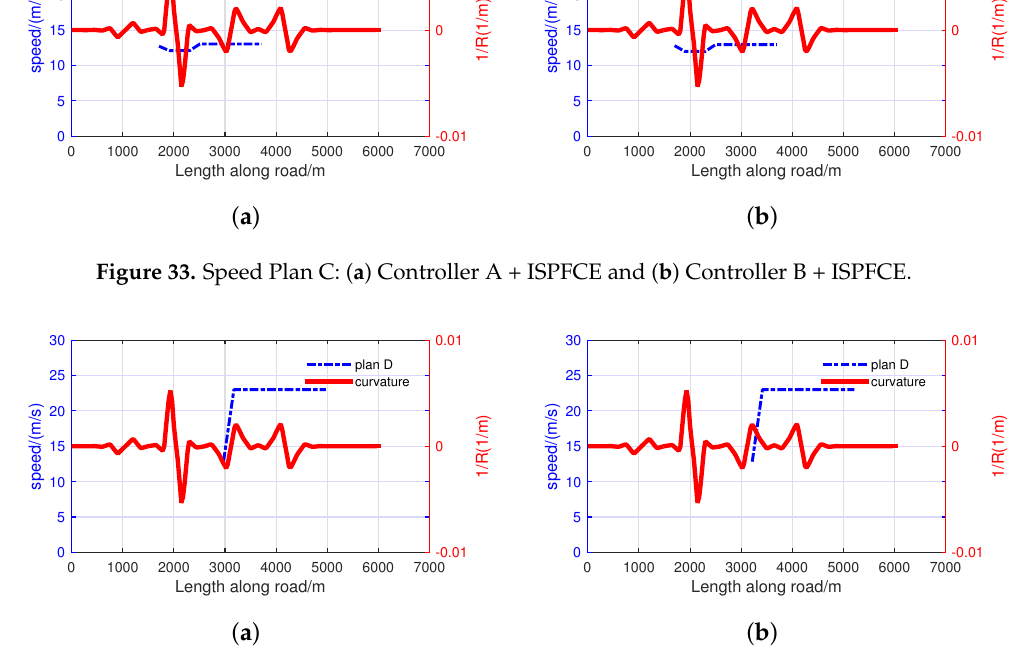
Figure 34. Speed Plan D: ( a ) Controller A + ISPFCE and ( b ) Controller B +